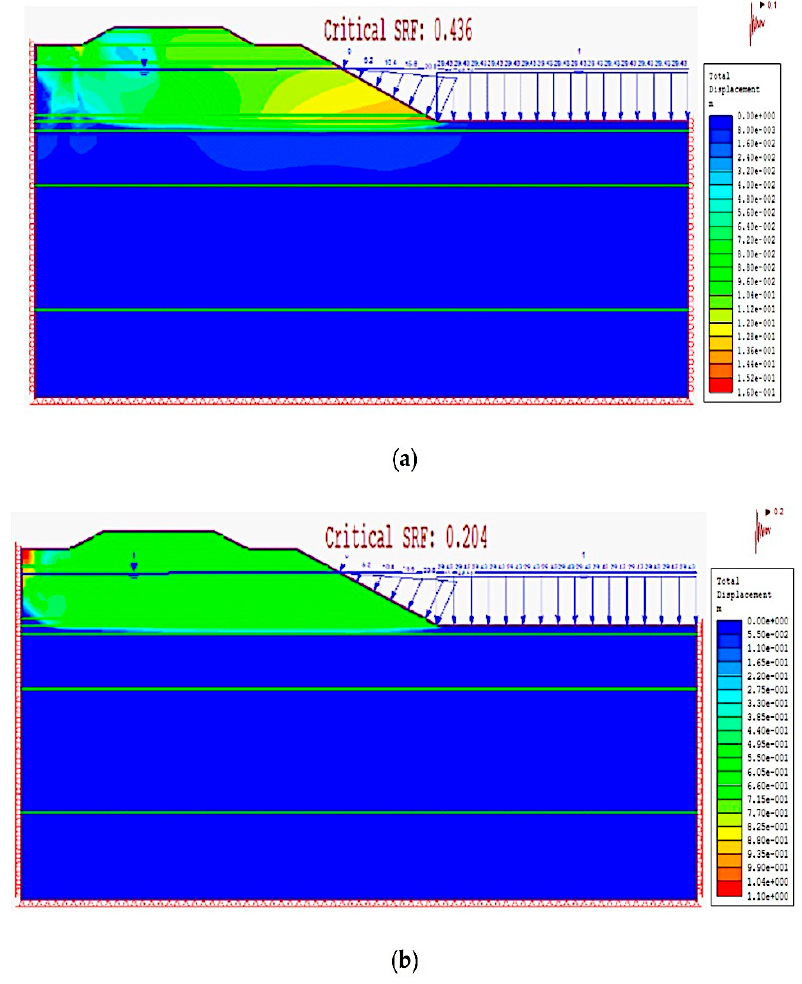
Figure 18. Colored contour shading of total displacement at earthquake acceleration changed by ( a ) 0.1 g and ( b ) 0.2 g.